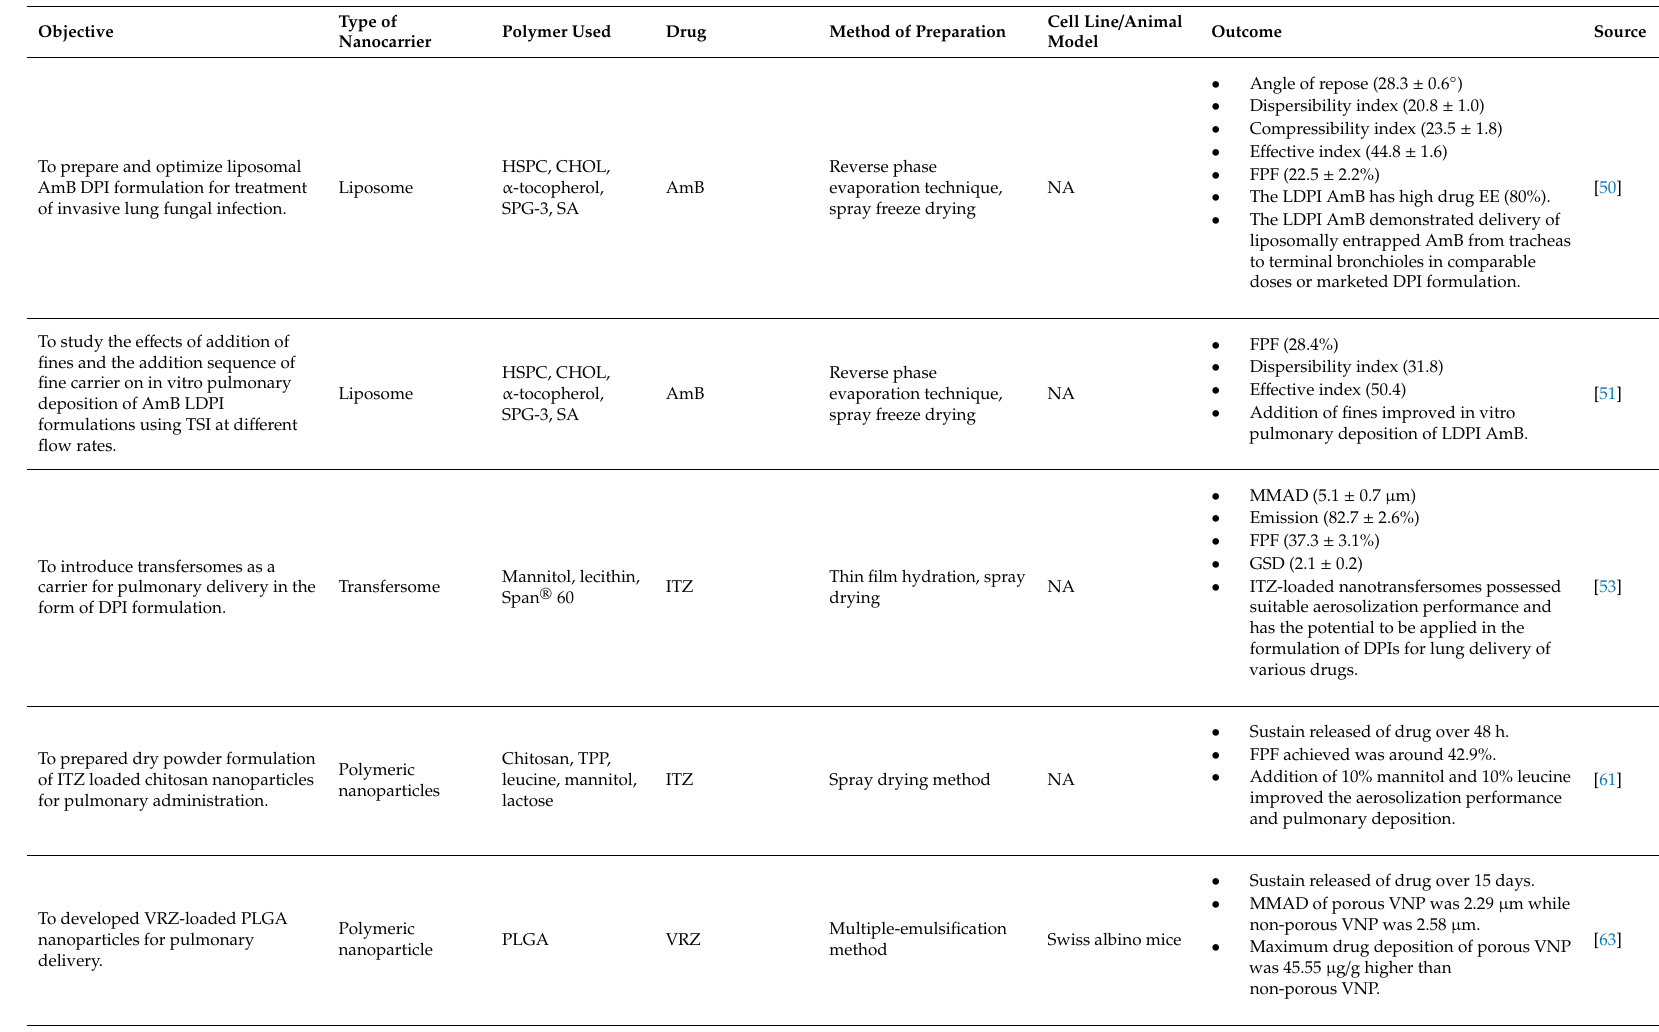
Table 2. Nanocarriers for lung delivery through